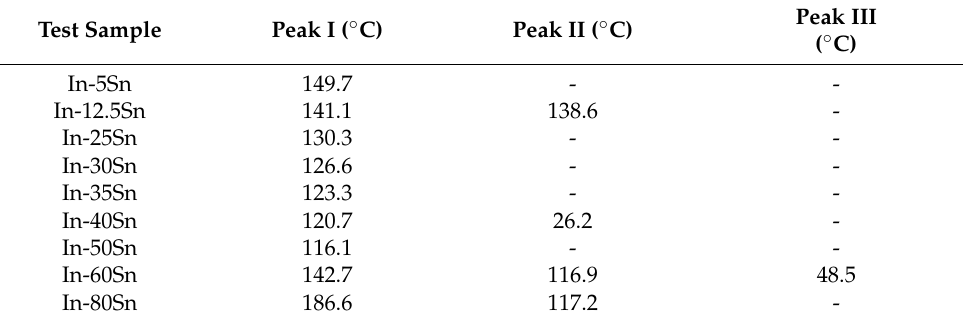
Table 2. Exothermic peak temperature of In-Sn solder alloys during